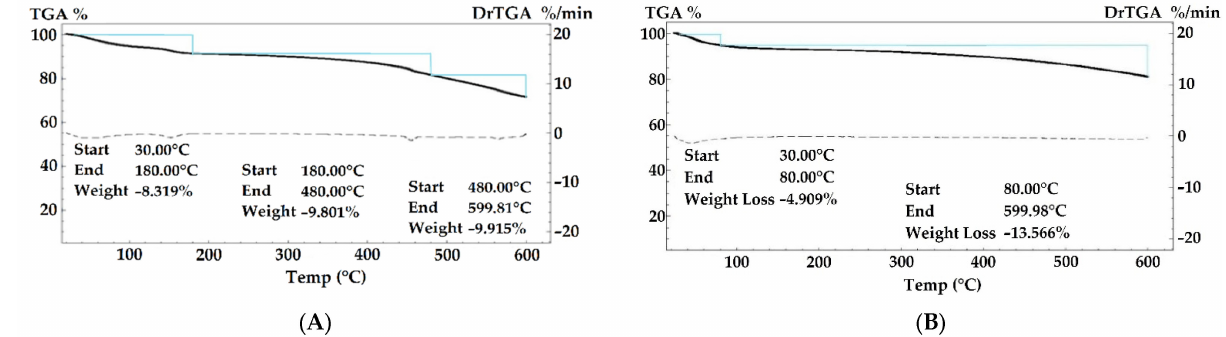
Figure 10. Thermogravimetry: ( A ) fresh biochar; ( B ) biochar after use as a filter